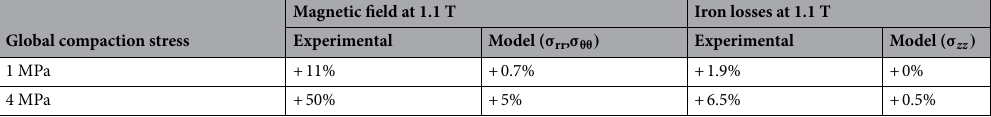
Global compaction